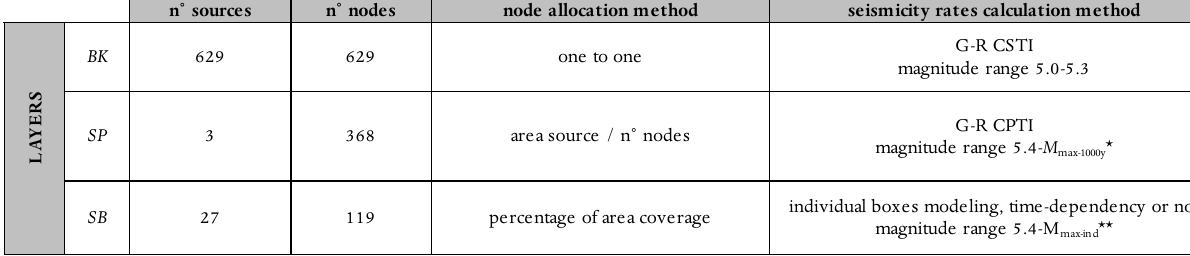
» and «expected T » represent the expected M max max